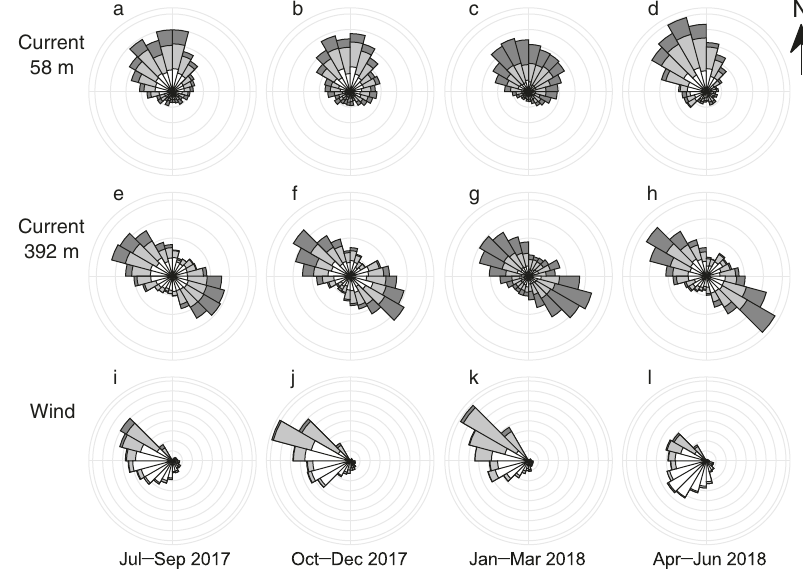
Fig. 4 Wind and current directions. Water current direction at the depths of ( a ) – ( d ) 58 m and ( e ) – ( h ) 392 m, for July – September 2017, October – December 2017, January – March 2018, and April – June 2018. White, light grey, and dark grey in ( a ) – ( h ) indicate the current speed of <10, 10 – 20, and >20 mm s ‒ 1 . ( i ) – ( l ) are the same for wind speed. White, light, and dark grey in ( i ) – ( l ) indicate wind speed of <5, 5 – 10, and >10 m s ‒ 1 .